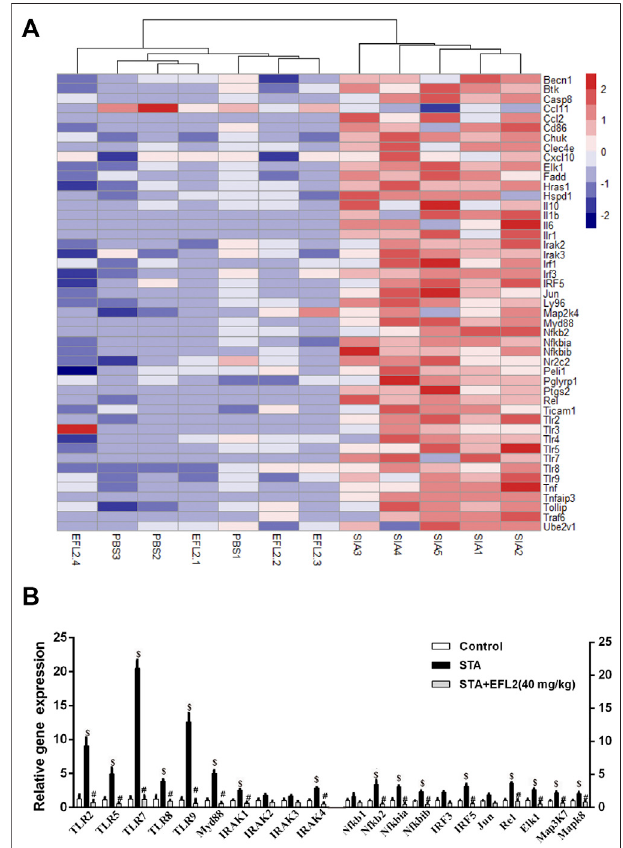
FIGURE 3 | Euphorbia factor L2 suppresses TLR signaling pathway activation (A) Heat map showing the log(fold-changes) in TLR signalling pathway genome in the ankles of mice. Color scale ranges from red to blue which respectively denotes the up- or down-regulated of the genes (B) RT-PCR veri fi ed the changes in the transcriptional regulators mRNA expression among control, STA and STA mice i. p. injected with EFL2 (40 mg/kg) (n (cid:1) 3 in control, n (cid:1) 5 in STA and EFL2 treated groups). Data represent the mean values ± SEM. * p < 0.05, ** p < 0.01, *** p < 0.001 were considered as signi fi cant. $ : STA versus Control, p < 0.05; #: STA + EFL2 treatment versus STA, p <